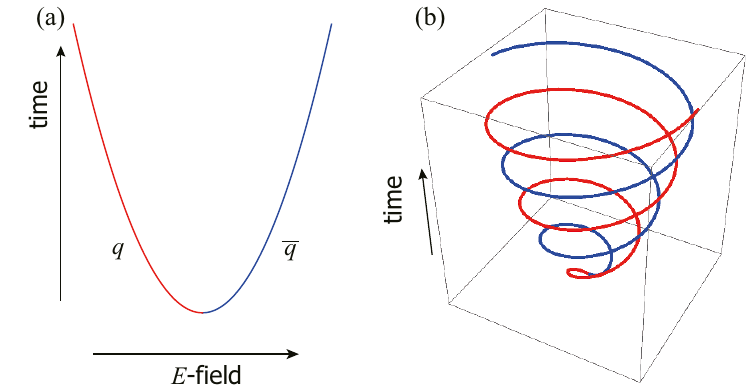
Figure 1 . Schematic illustration of the DC and AC-Schwinger e(cid:11)ects. (a) DC-Schwinger e(cid:11)ect: in static electric (cid:12)elds, the quark-antiquark pair is created from the vacuum and are pulled away from each other by the (cid:12)eld. (b) AC-Schwinger e(cid:11)ect: in rotating electric (cid:12)elds, the created quark and antiquark rotate around each other as they are